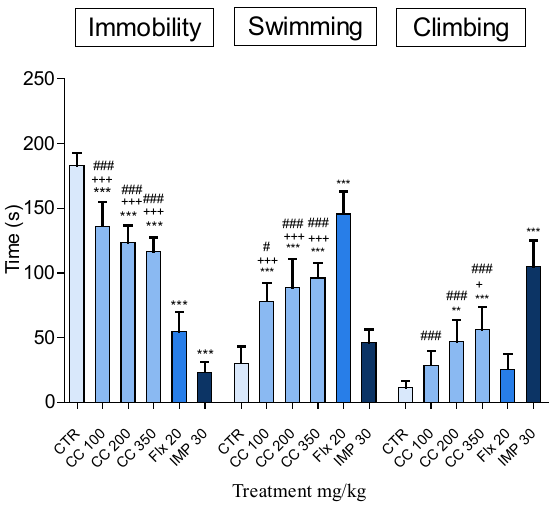
Figure 1. The Effects of CC Essential Oil, Fluoxetine, and Imipramine on the Mean Immobility, Swimming, and Climbing Times in FST. Note . Values are presented as mean ± SD. Significant differences between the groups were assessed using the one-way ANOVA, followed by Tukey’s test. * , ** , and *** show significant differences between the vehicle (control) group at P < 0.05, P < 0.01, and P < 0.001 in immobility time, swimming time, and climbing time, respectively. In addition, + , ++ , and +++ indicate significant differences between the CC group and fluoxetine at P < 0.05, P < 0.01, and P < 0.001 in immobility time, swimming time, and climbing time, respectively. Further, # , ## , and ### demonstrate significant differences between the CC group and imipramine at P < 0.05, P < 0.01, and P < 0.001 in immobility time, swimming time, and climbing time, respectively. CTR: Control; CC: Cuminum cyminum ; Flx :Fluoxetine; IMP: Imipramine; SD: Standard deviation TST: Tail suspension test; ANOVA: Analysis of variance.